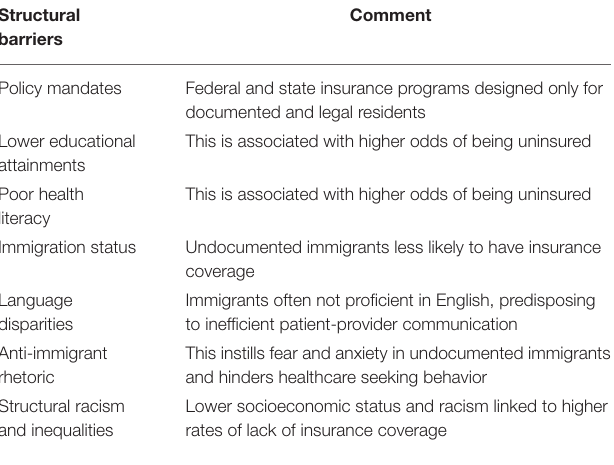
TABLE 1 | Structural barriers to accessing healthcare services.